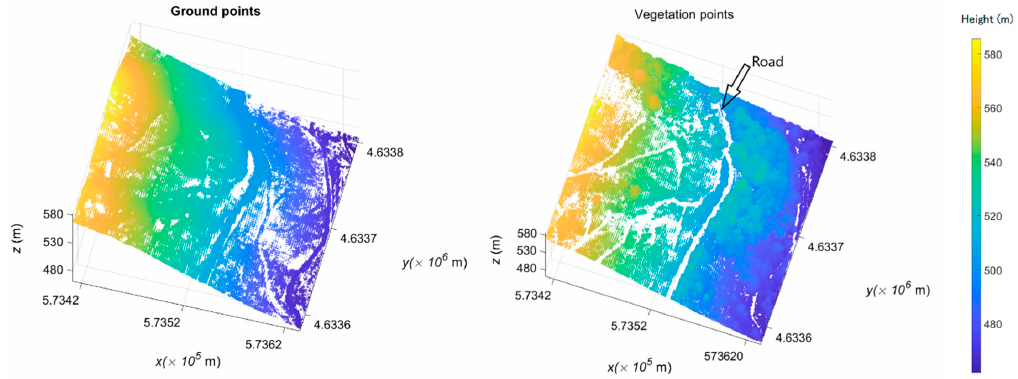
Figure 6. Point cloud classification. Ground points (left) and vegetation points (right).